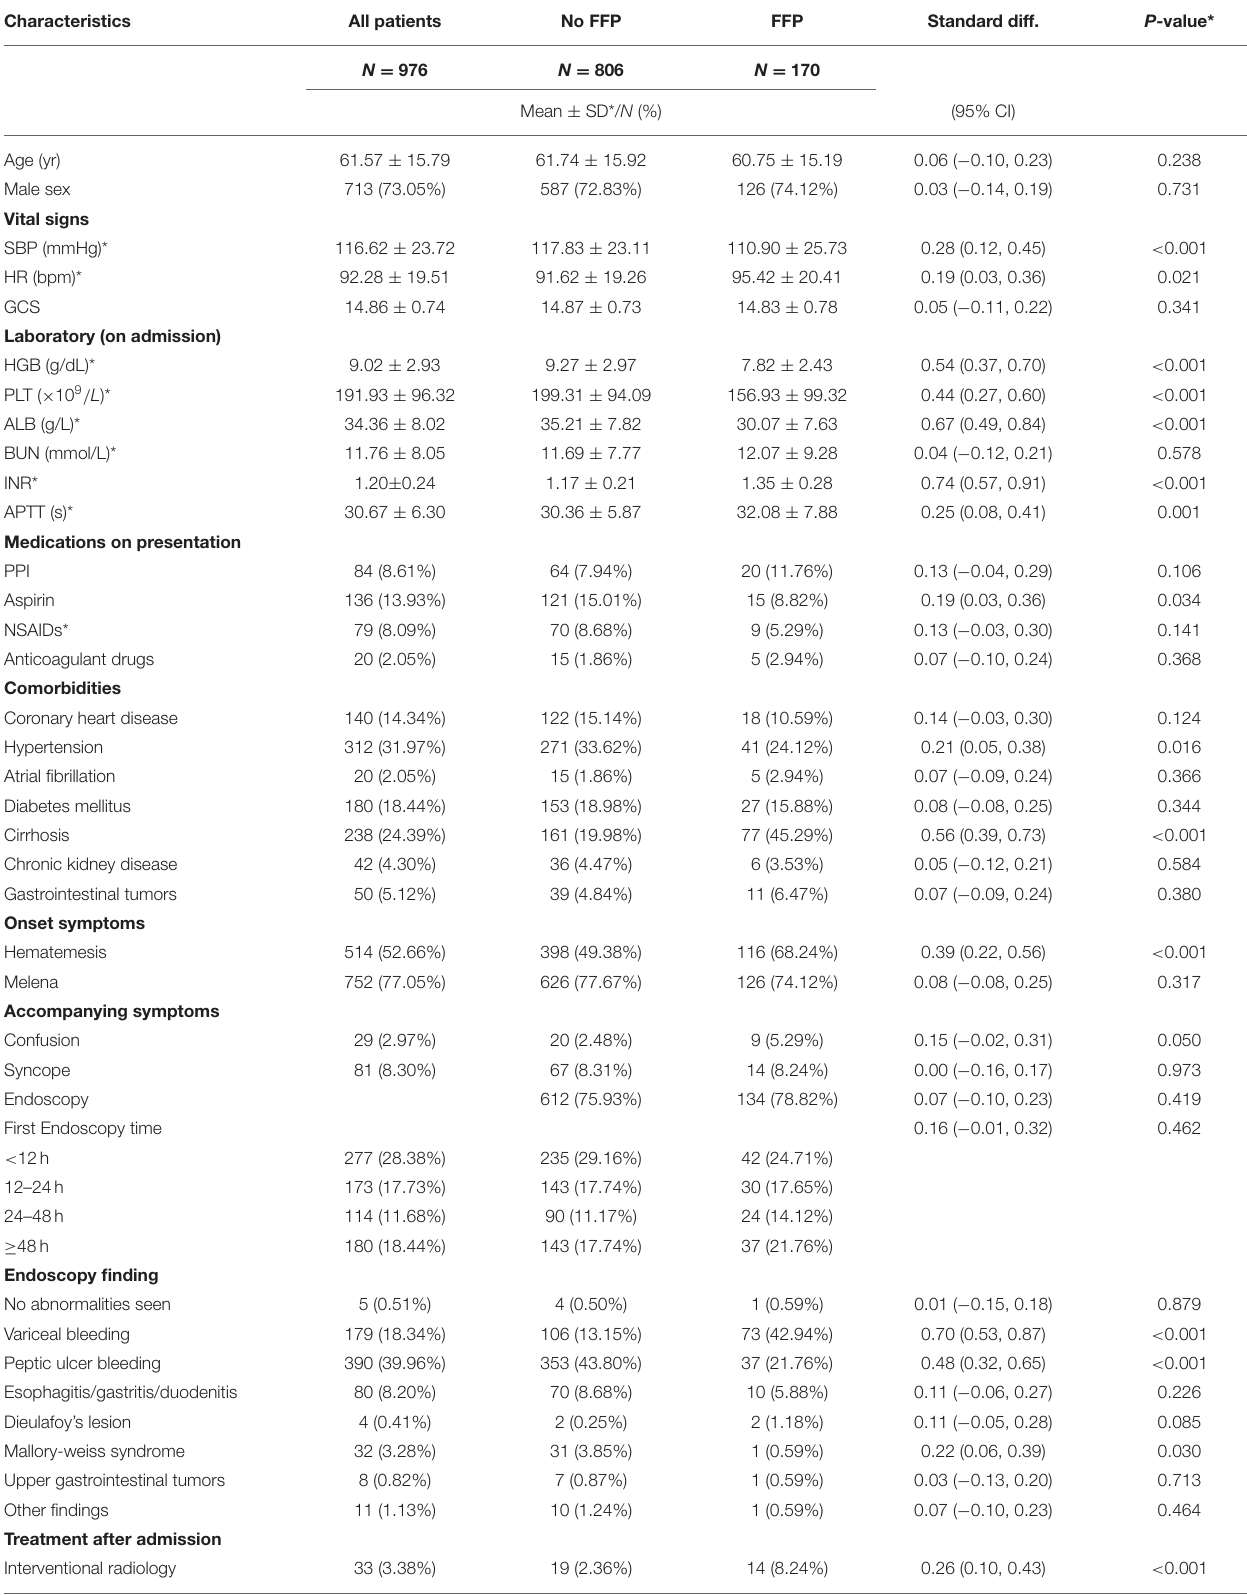
TABLE 1 | Baseline characteristics of the two groups.